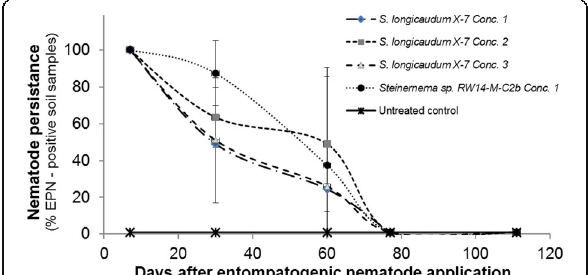
Fig. 5 Percentage of entomopathogenic nematode-positive soil samples collected from two experimental Irish potato fields in Rwanda treated with entomopathogenic nematodes. Nematode concentration 1=0.75×10 9 infective juveniles (IJs)/ha; concentration 2=1.5×10 9 IJs/ha; concentration 3=2.5×10 9 IJs/ha. Field M in Musanze and field N in Nyamagabe districts in Rwanda in 2015. Four plots assessed per treatment per field per time step. GLM revealed treatment effects, but Tukey multiple comparison did not detect differences between each treatment combination. Error